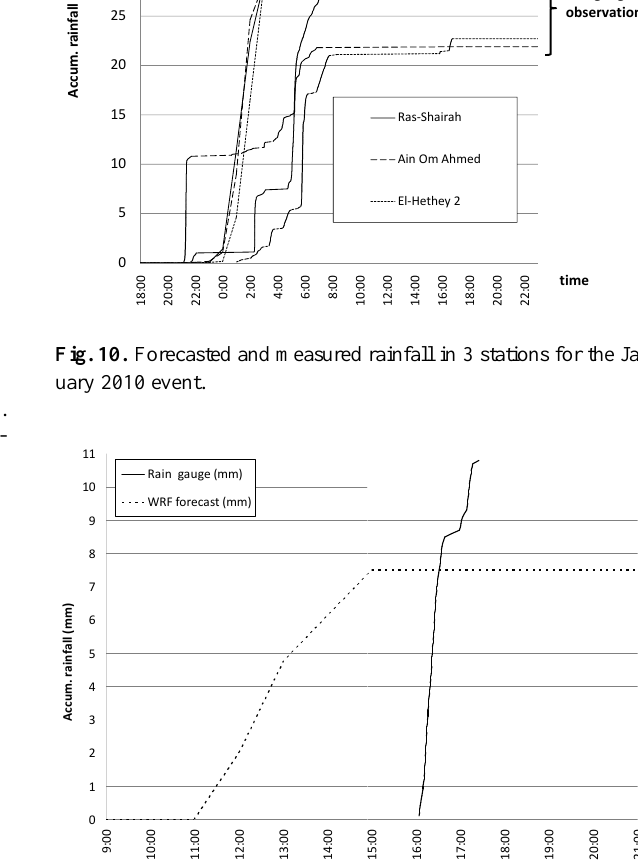
Fig. 9. Forecasted and measured rainfall in 8 stations for the Jan- uary 2010 event (ranked by measured rainfall).